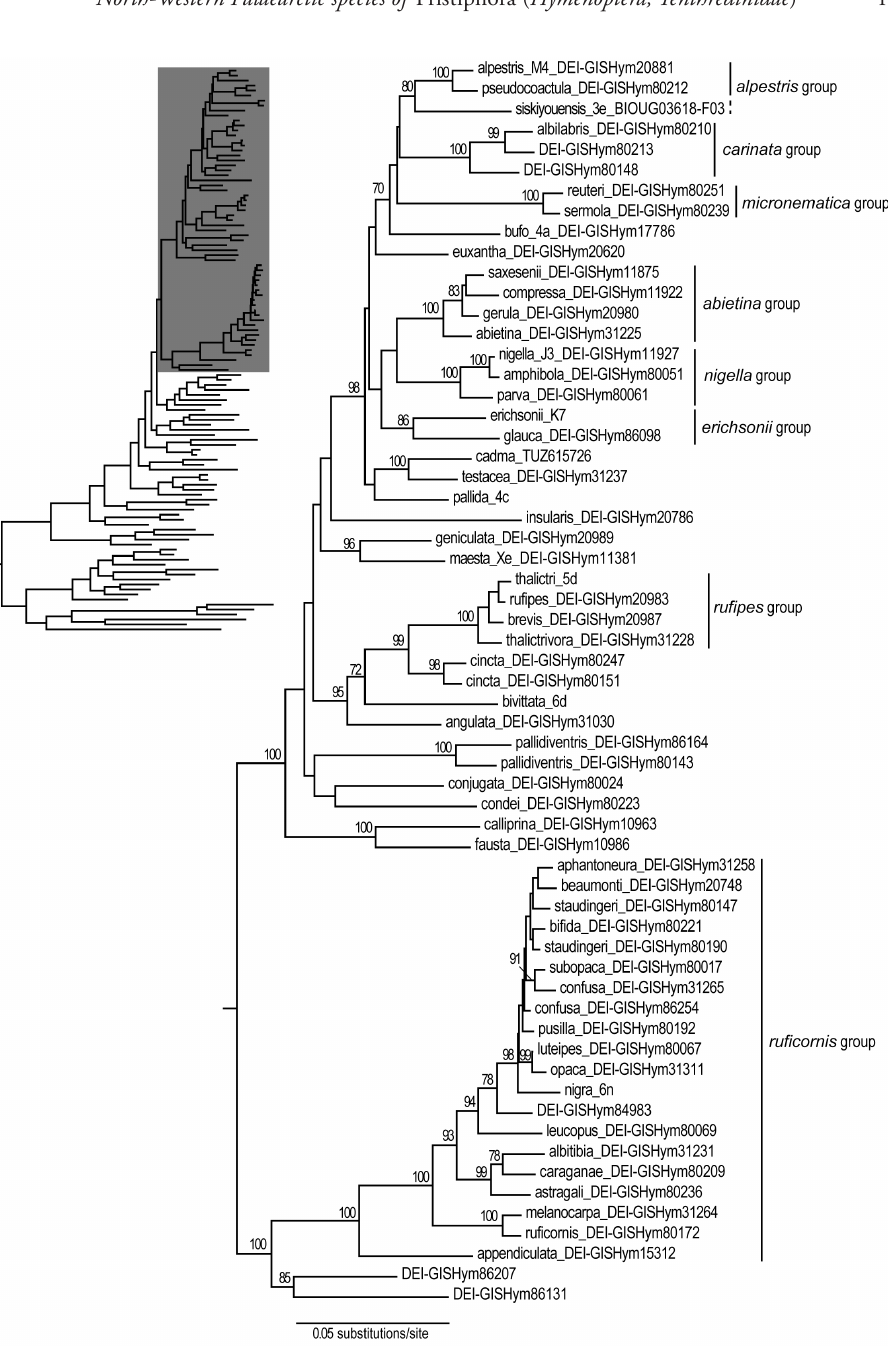
Figure 2. Part of the maximum likelihood tree shown in Fig. 1. Numbers above branches show bootstrap proportions (%). Support values for weakly supported branches (BP<70) are not shown. Outline of the full tree is shown upper left, with the part shown here highlighted. The scale bar shows the number of estimated substitutions per nucleotide